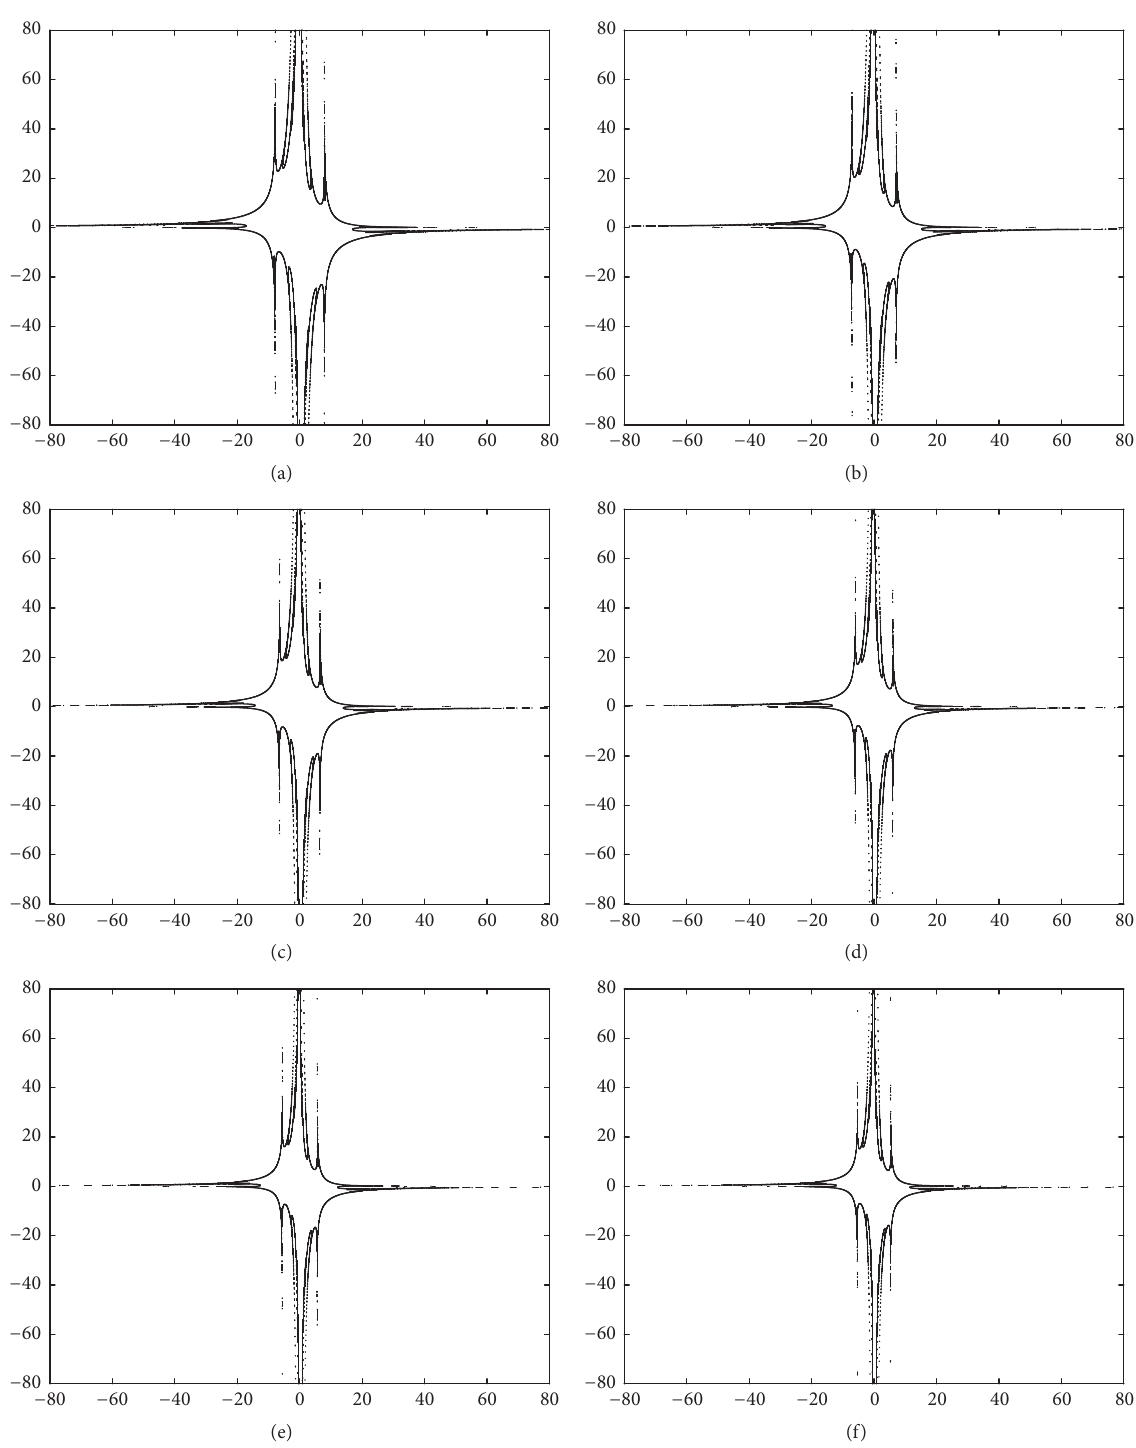
Figure 6: The change of the Julia sets of the controlled system when 𝑎 = 0.07 , 𝑏 = 0.02 , and 𝛾 = 0.01 . (a) 𝑘 = 0.64 ; (b) 𝑘 = 1.04 ; (c) 𝑘 = 1.44 ; (d) 𝑘 = 1.84 ; (e) 𝑘 = 2.24 ; (f) 𝑘 = 2.6